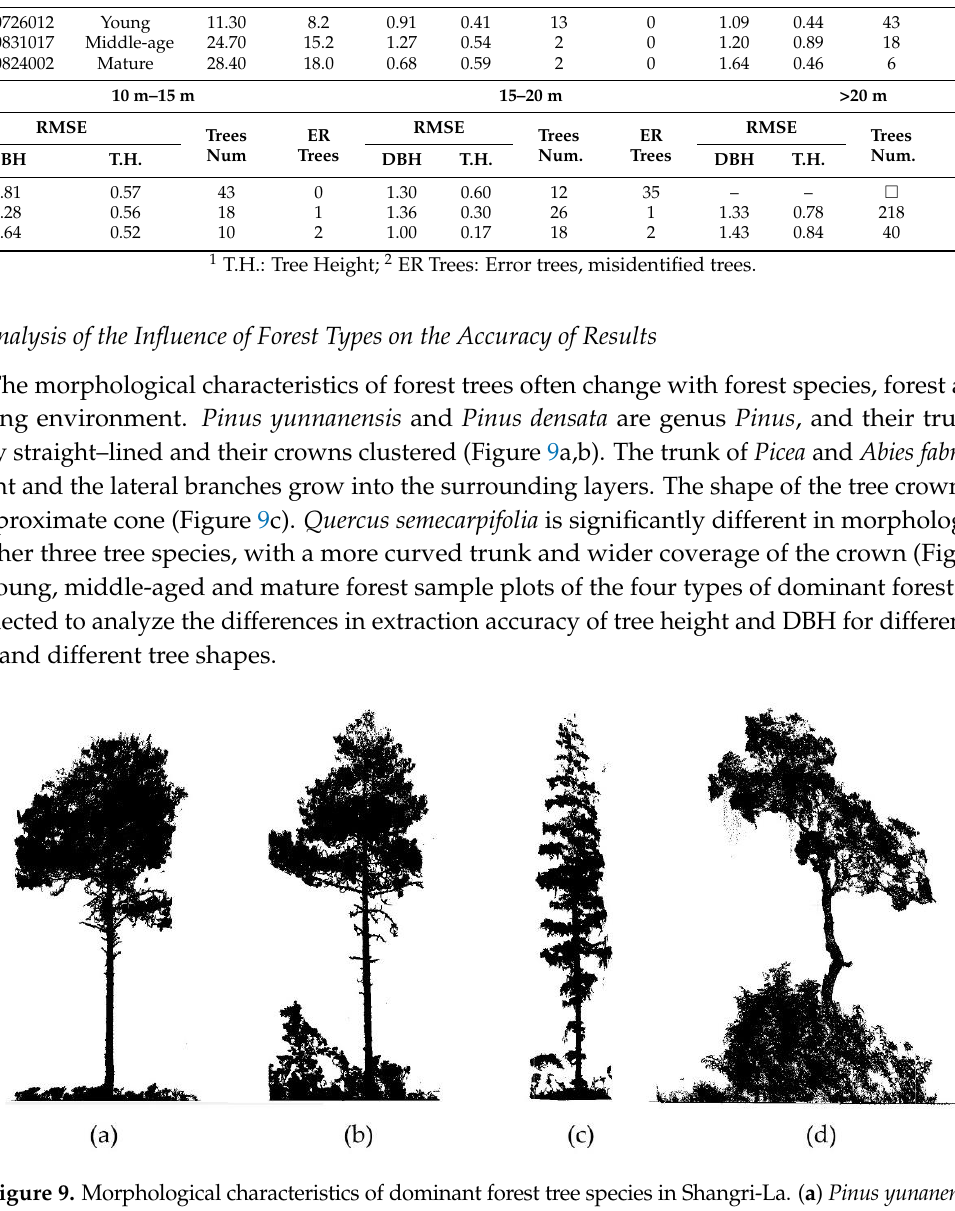
Figure 9. Morphological characteristics of dominant forest tree species in Shangri-La. ( a ) Pinus yunanensis ; ( b ) Pinus densata ; ( c ) Picea & Abies fabri ; ( d ) Quercus semecarpifolia .